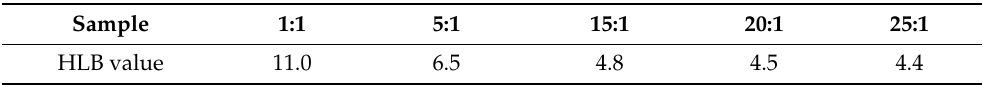
Table 3. HLB values of PBA-g-PDMAEMA